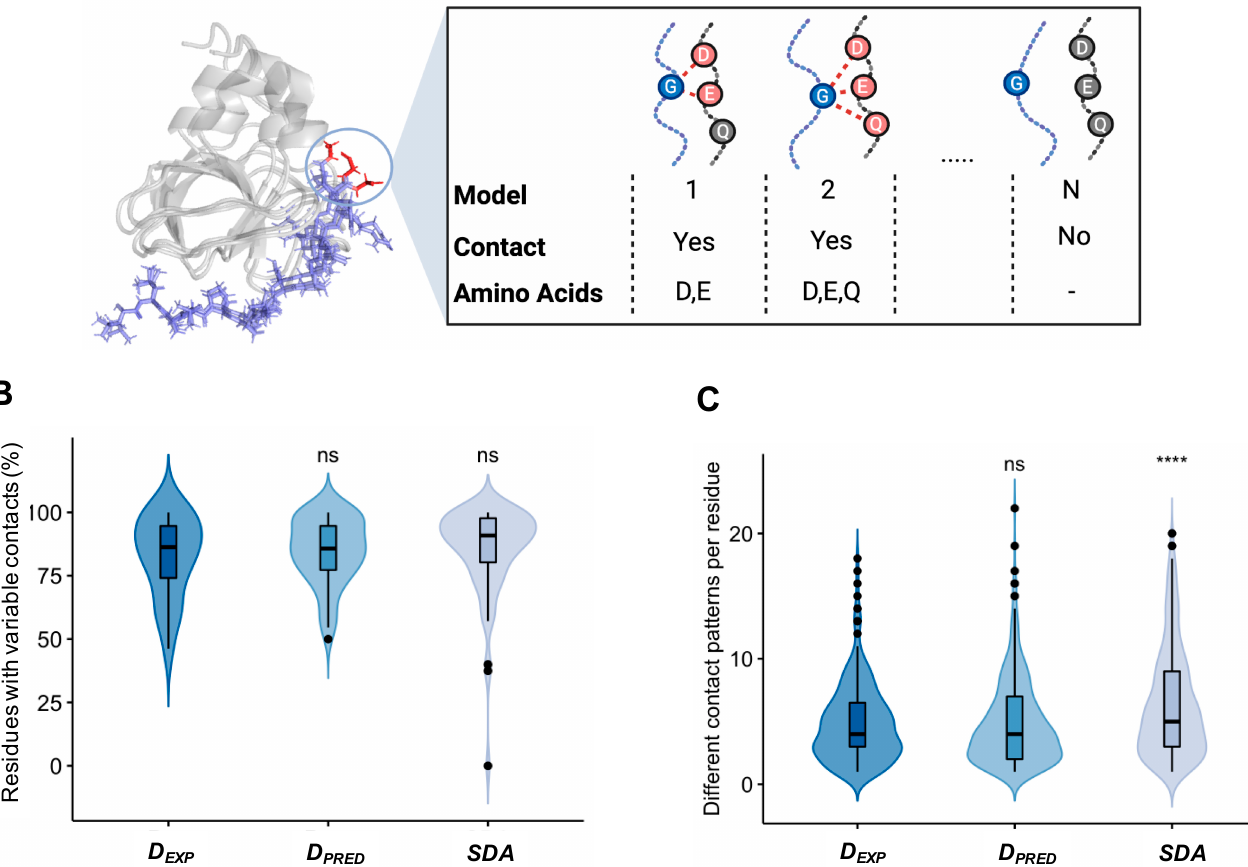
Figure 4. Contact-pattern variability in specific complexes of experimental droplet-driving proteins (D EXP ), predicted droplet-driving proteins (D PRED ) and specific disordered assemblies (SDA). ( A ) Definition of different contact patterns, as illustrated by the complex of Myc proto-oncogene protein (blue) with Myc box–dependent interacting protein 1 (gray) (PDB:1mv0). Contacting residues (in any of the conformers) are shown in red. ( B ) Percentage of residues with changing contact patterns in the ensemble. ( C ) Frequency of the different contact patterns within the conformational ensembles of the three groups of disordered assemblies. The disordered assemblies of experimental droplet-driving proteins (D EXP ), predicted droplet-driving proteins (D PRED ) and specific disordered assemblies (SDA) exhibit similar degrees of interaction variability. Specific disordered assemblies of those proteins, which are not known to phase separate, exhibit more contact patterns than those of droplet-driving proteins. Statistical significances were computed by the Mann–Whitney test, using the R program (ns: p > 0.05, **** p ≤